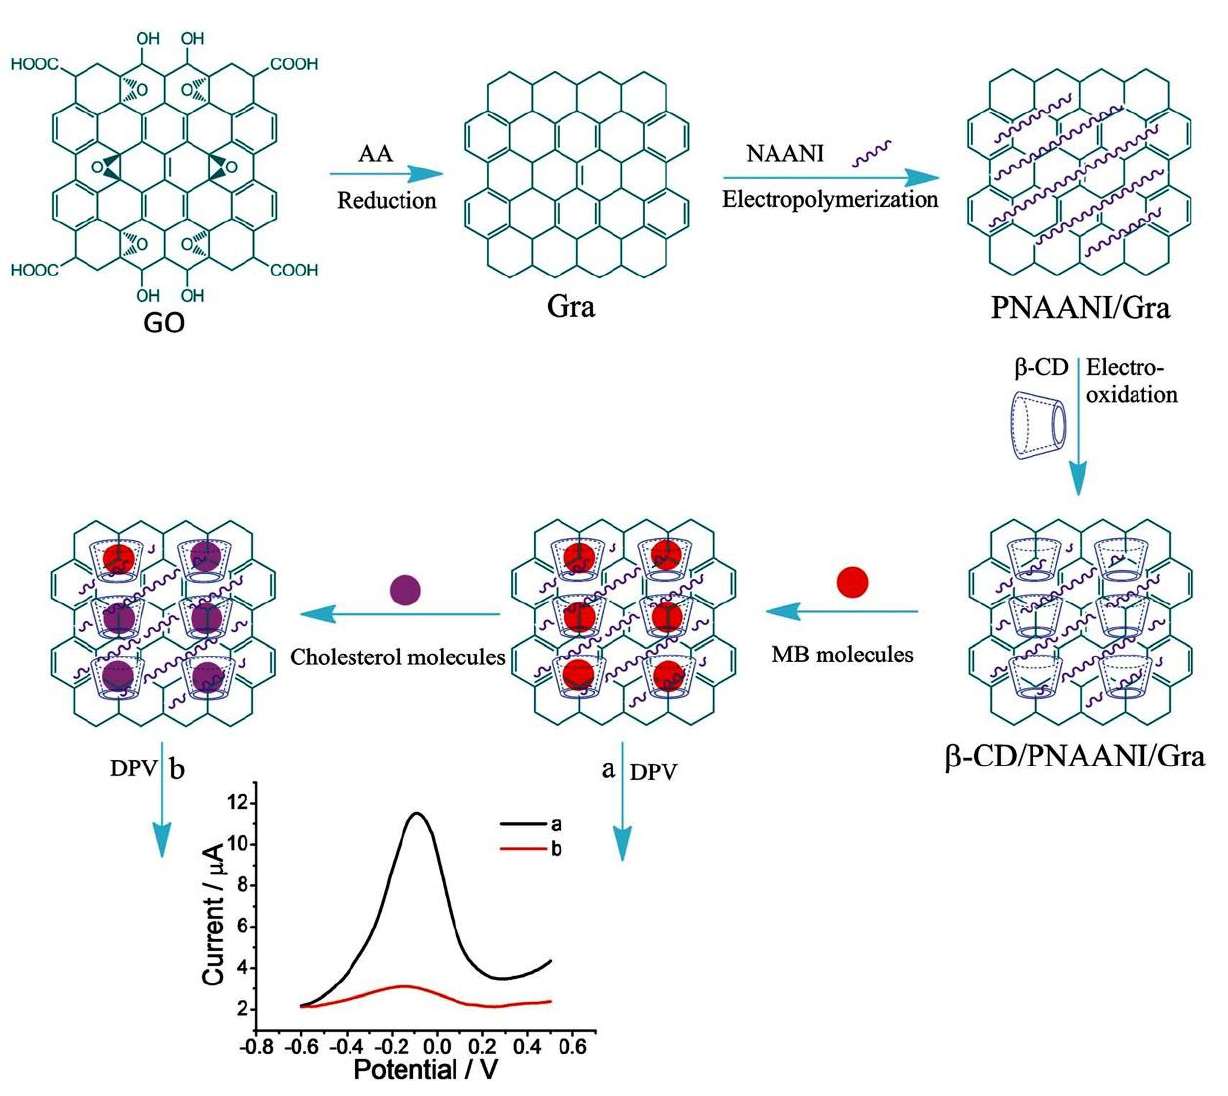
Figure 9. Electrochemical sensor based on the competitive host–guest interaction between β–CD and MB (signal probe)/cholesterol (target) [51]. Reprinted with permission from ref. [51]. Copyright 2011 Royal Society of Chemistry.